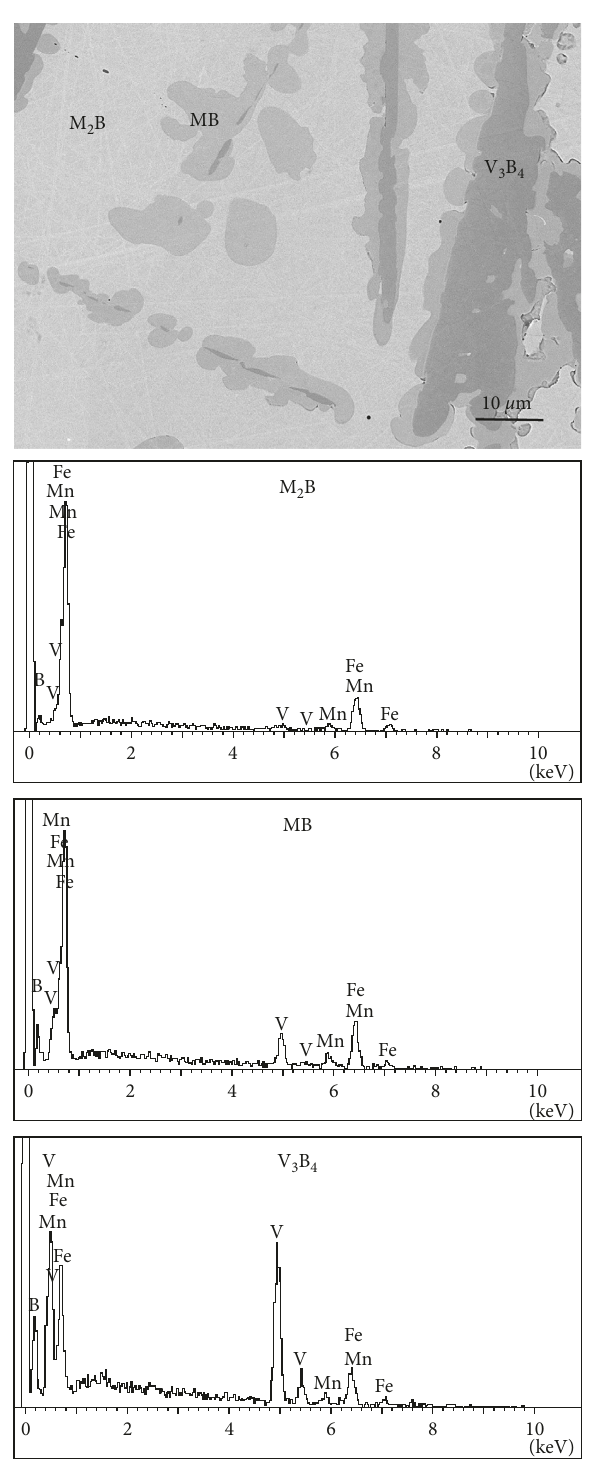
Figure 6: Microstructure of the alloy 1 after annealing with the EDX spectrum of identified phases.